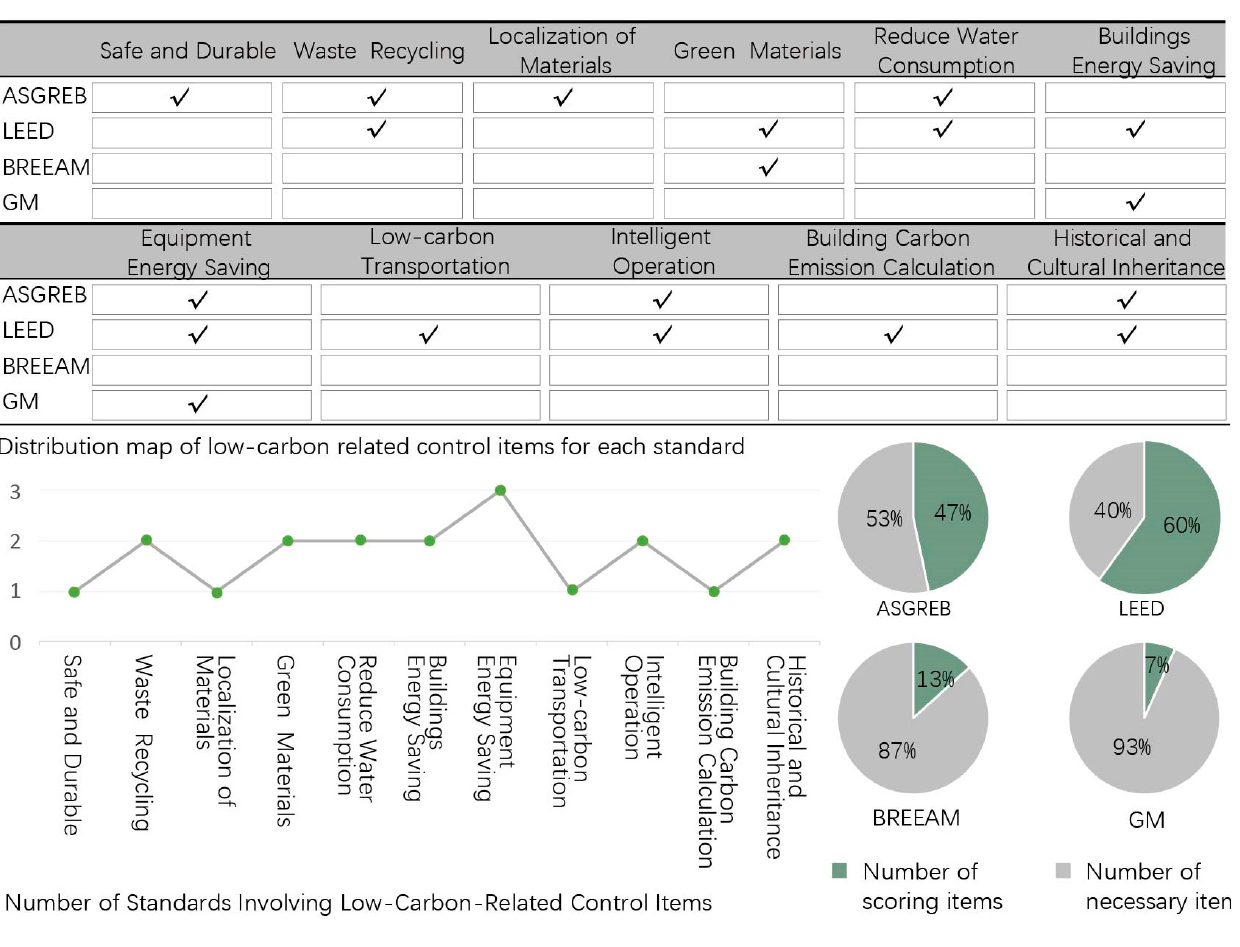
Figure 8. Analysis of necessary and recommended items.